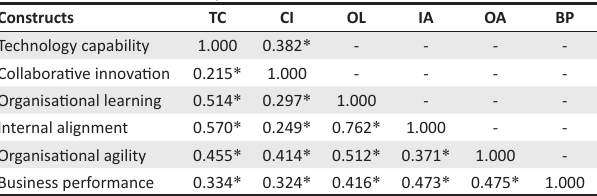
TABLE 4: Discriminant validity.